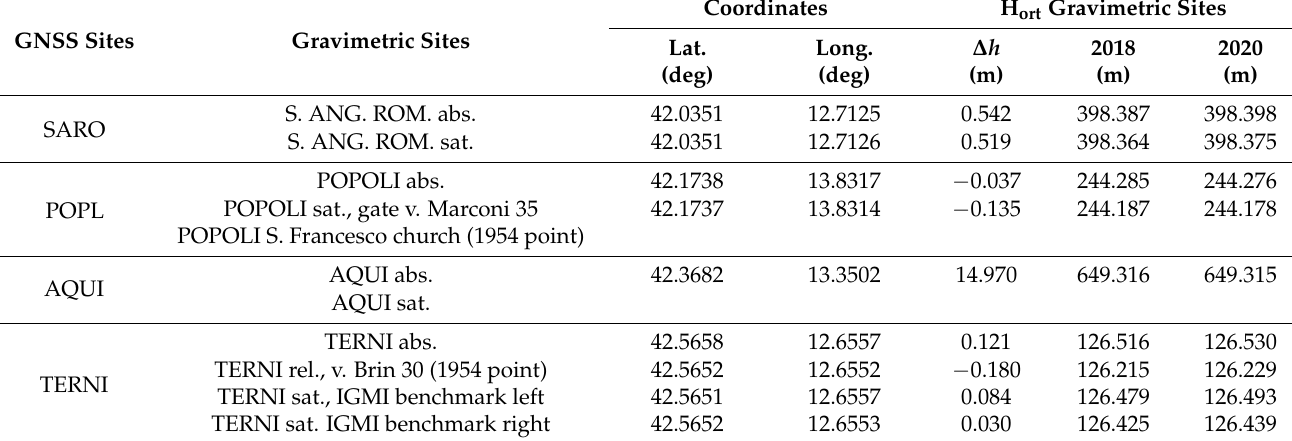
Table 3. Coordinates, measured height differences between GNSS sites, and indoor (abs.) plus satellite (sat.) gravity sites in 2018 and 2020. The orthometric heights of the gravimetric sites are computed applying ∆ h to the orthometric height of GNSS sites (Table 2). The monograph of each point is available in [25].